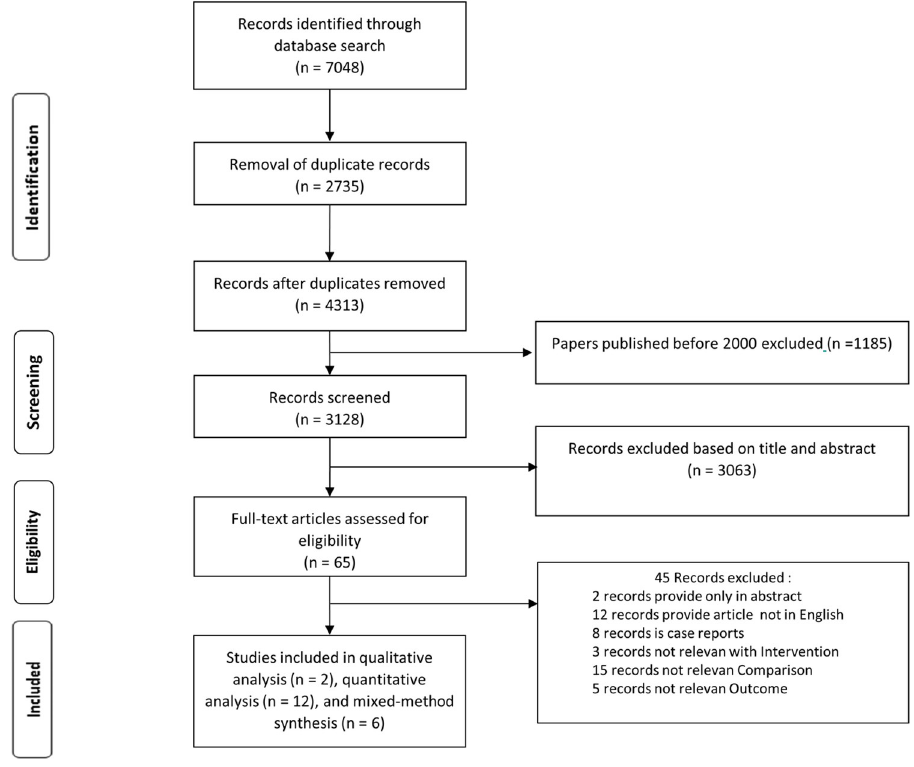
Fig 1. Flow diagram of the selection